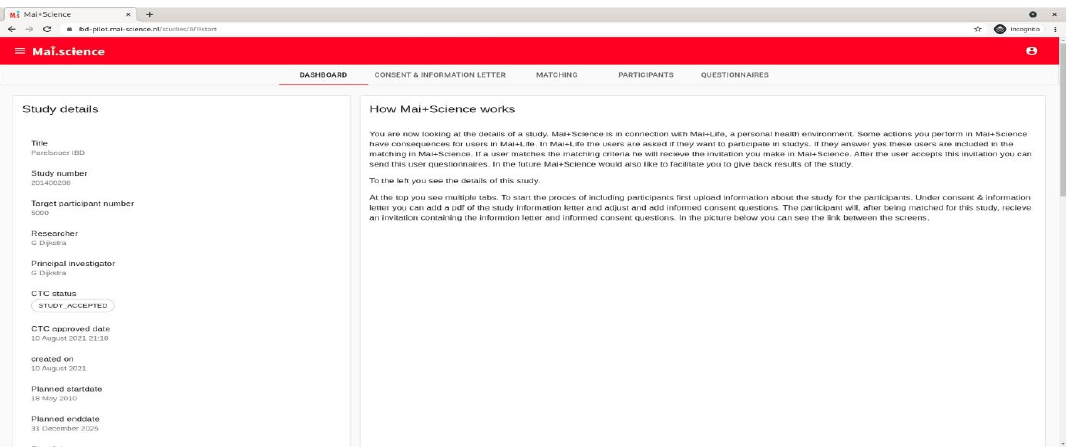
Figure 3. Screenshot of Mai+Science dashboard.